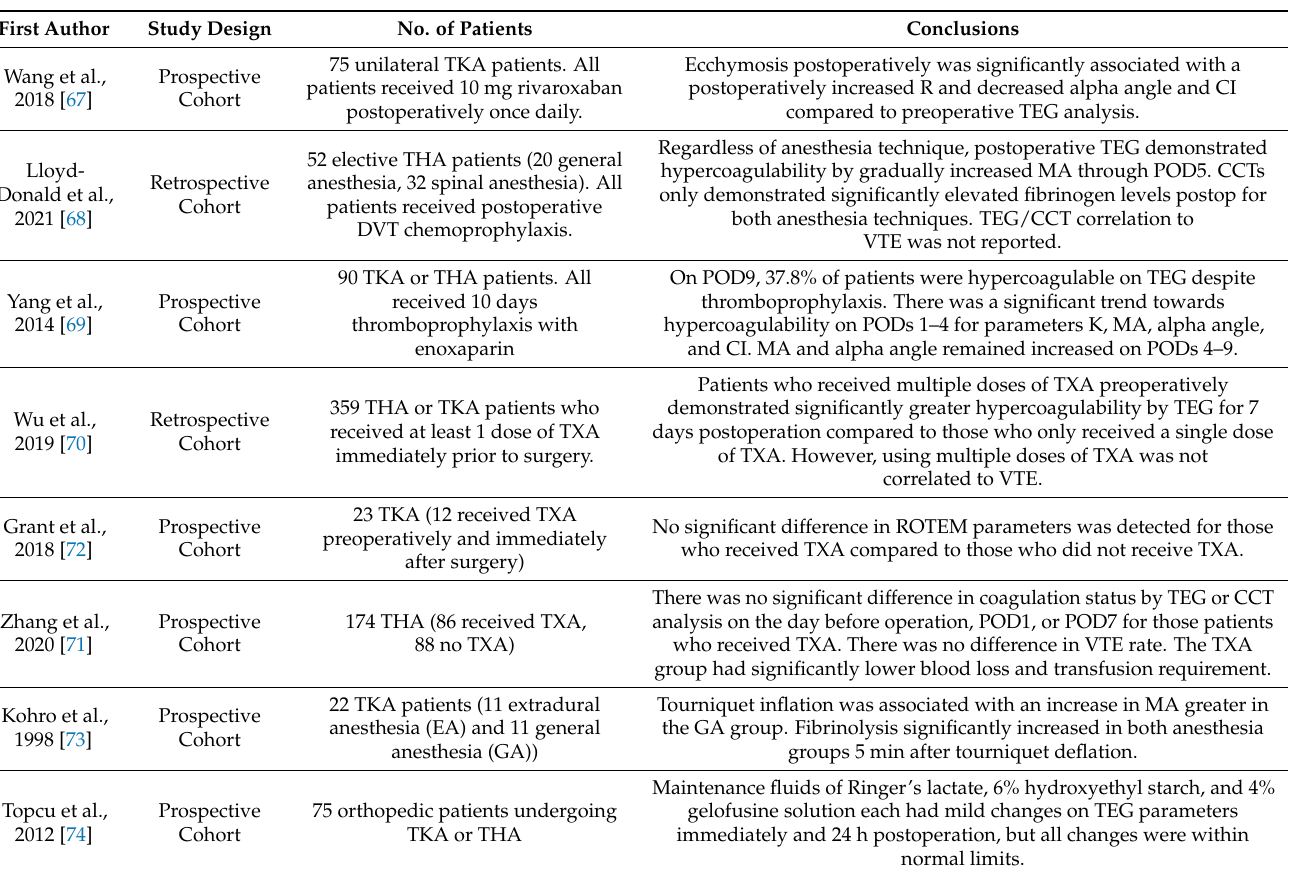
Table 5. Summary of the literature pertaining to viscoelastic hemostatic assays applied to patients undergoing